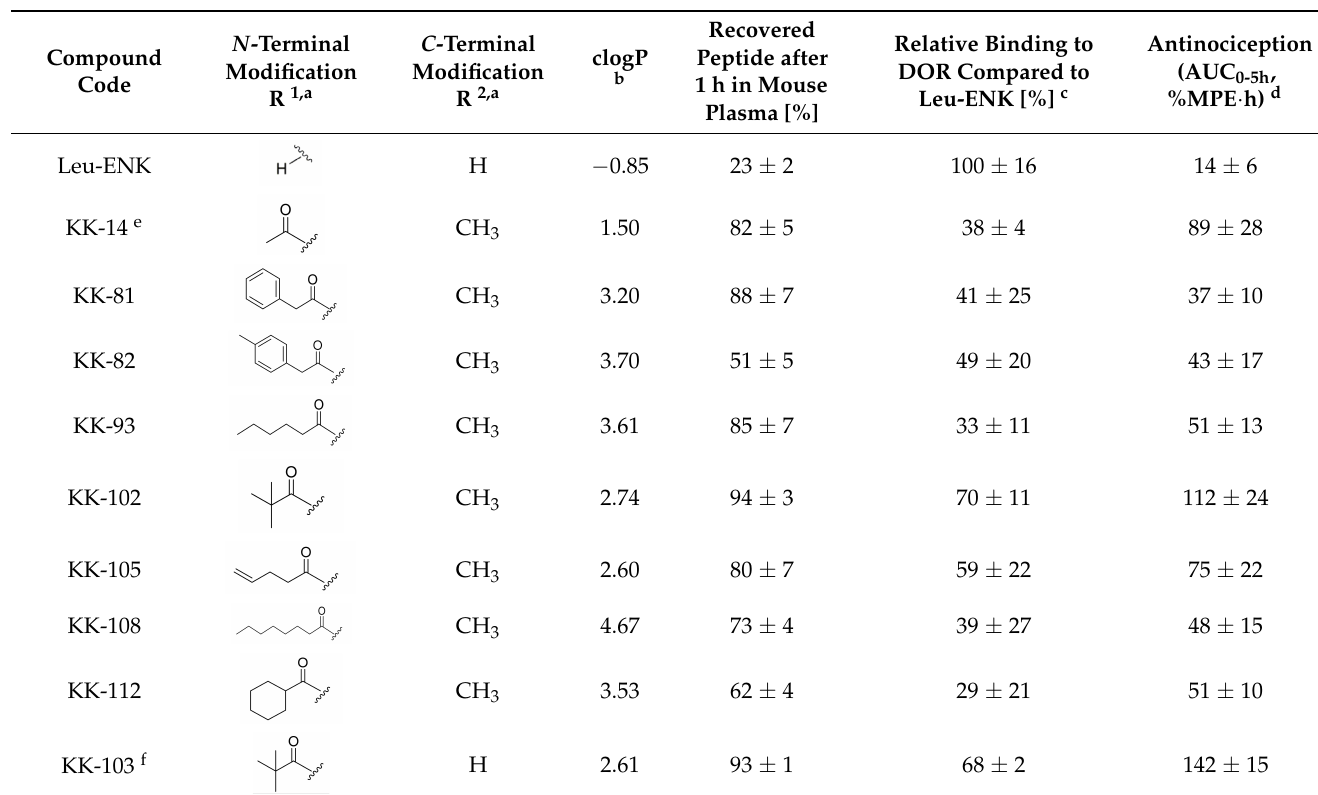
Figure 1. Chemical structure of Leu-ENK (sequence: YGGFL) and the sites of N -terminal (shown as R 1 ) and C -terminal (shown as R 2 ) modifications. The chemical structures of R 1 and R 2 within the general sequence R 1 HN-YGGFL-COOR 2 are provided in Table 1. Table 1. In vitro characteristics and in vivo antinociceptive activity of Leu-ENK analogs (general sequence: R 1 HN-YGGFL- COOR 2